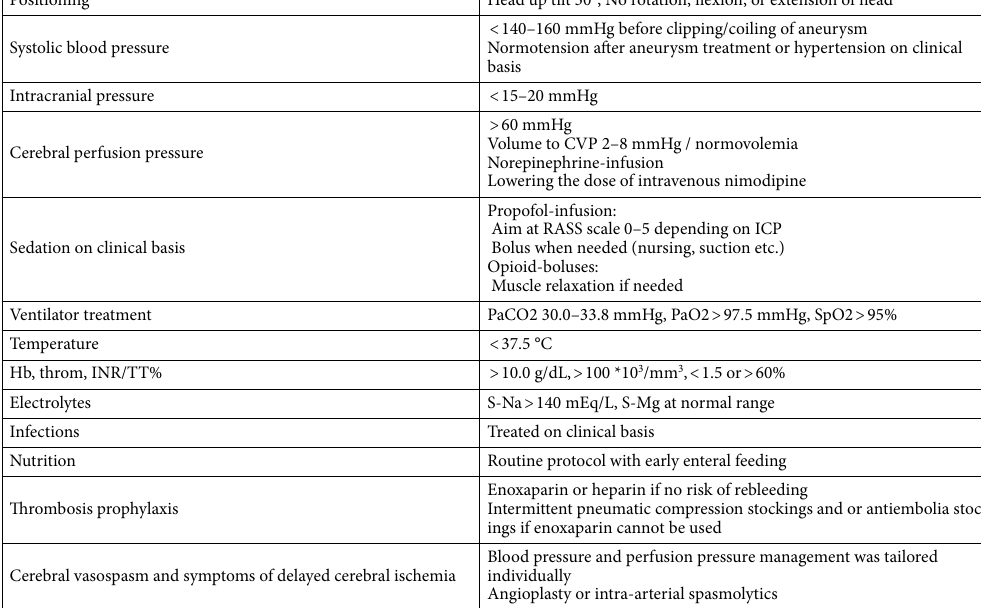
Table 2. The intensive care treatment protocol. °C degrees Celsius, CVP central venous pressure, Hb hemoglobin, ICP intracranial pressure, INR international standardized ratio, mmHg millimeters of mercury, PaCO2 partial pressure of carbon dioxide, PaO2 partial pressure of oxygen pressure, RASS Richmond agitation sedation scale, SpO2% peripheral capillary oxygen saturation percent, Throm thrombocytes, TT% thromboplastin